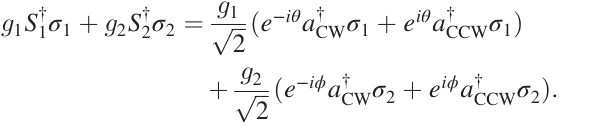
FIG. 12. Bath and cavity operators for a disk resonator coupled to a single bus waveguide along with a scattering port.